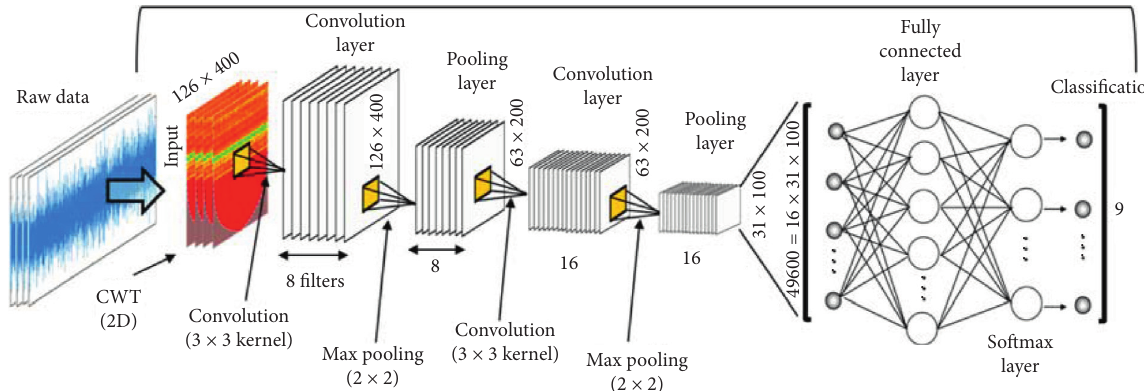
Figure 9: Convolutional neural network architecture with two stages.